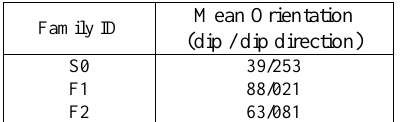
Table 8. DiscontinuityLab results for the mean orientation of the set families for the Saulges cliff